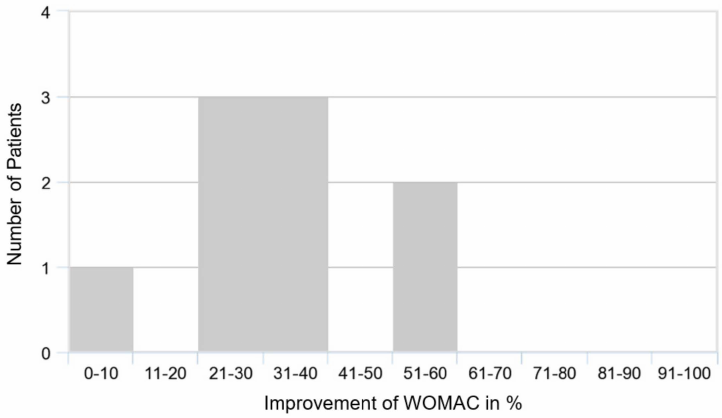
Figure 4. Improvement of the WOMAC score in total, over a period of six